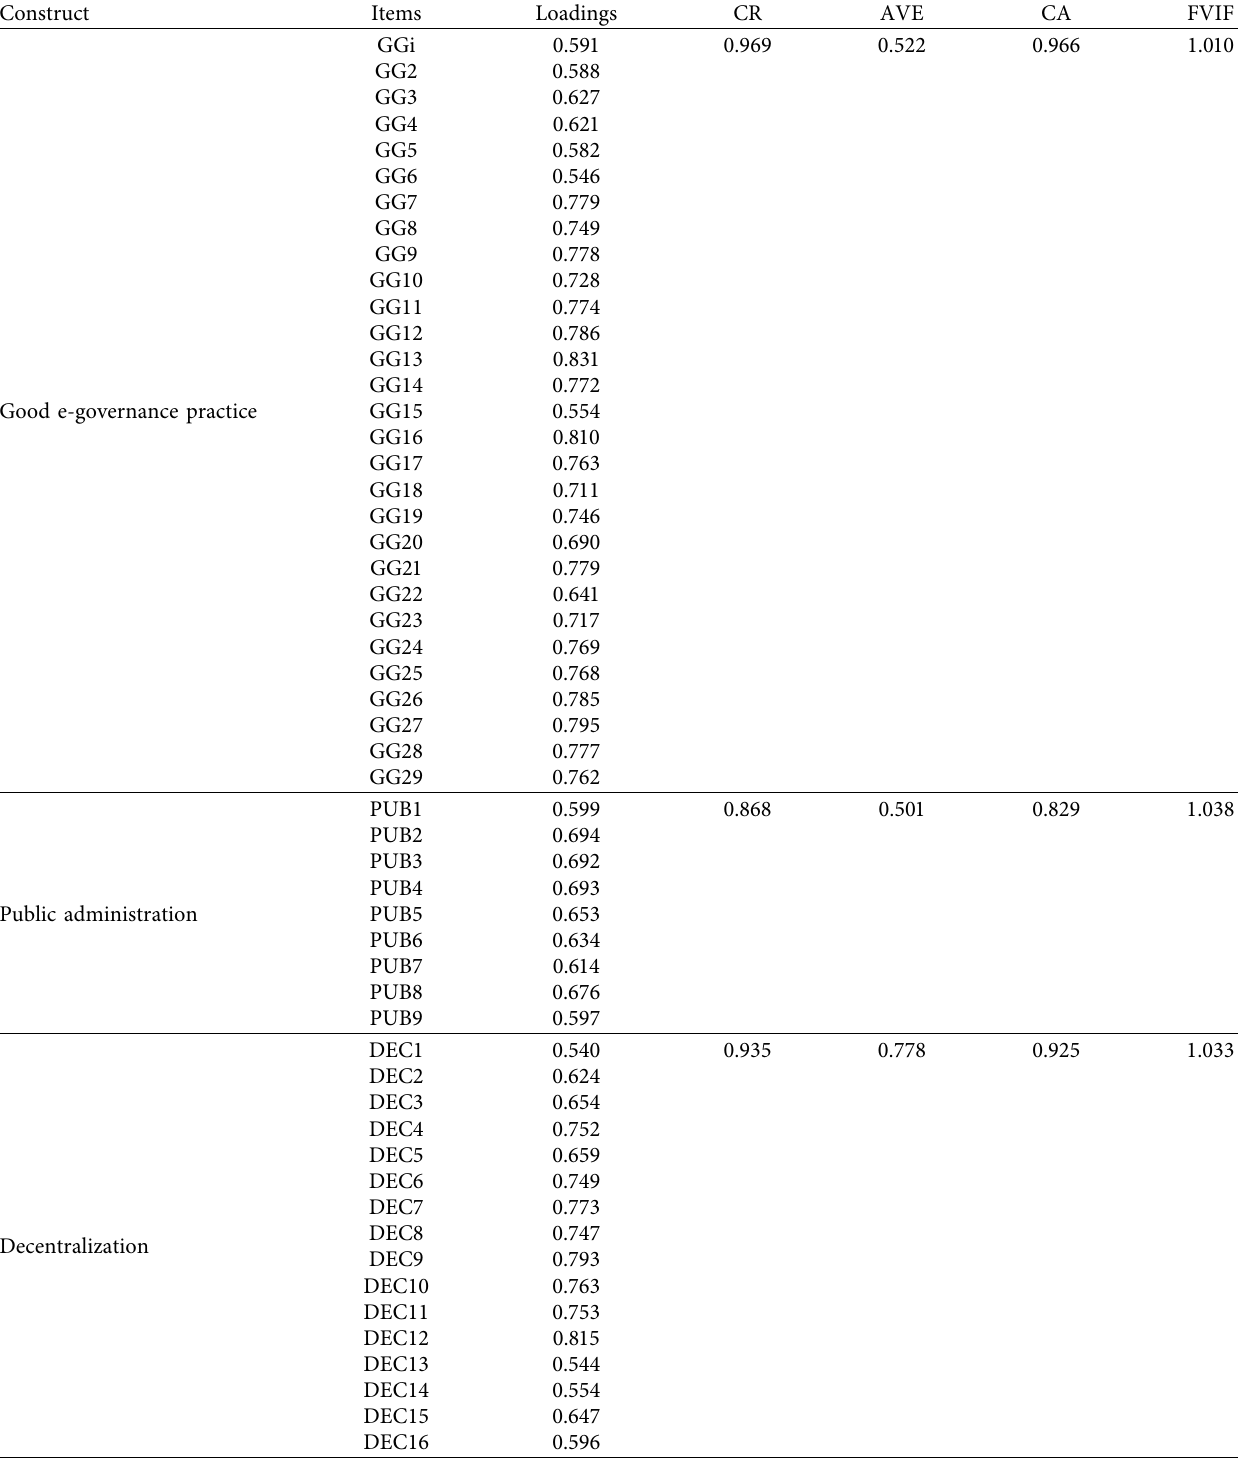
Table 3: Model measures’